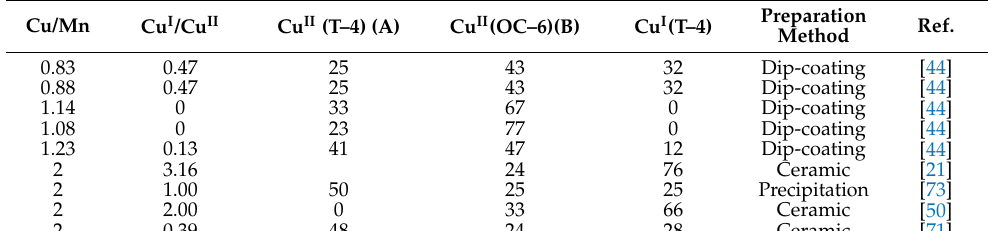
Table 3. Distribution of copper ions between the T–4 and OC–6 sites of the spinel lattice in Cu x Mn 3 − x O 4 samples.